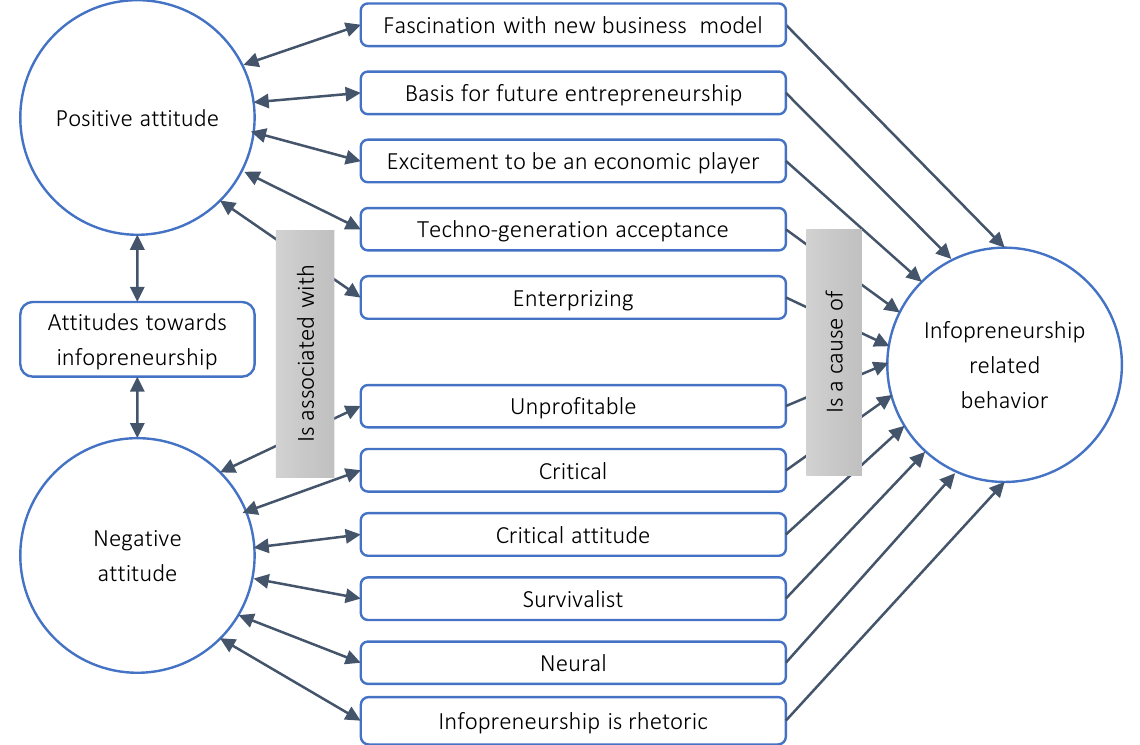
Figure 2. Network diagram for the attitudes of respondents towards infopreneurship